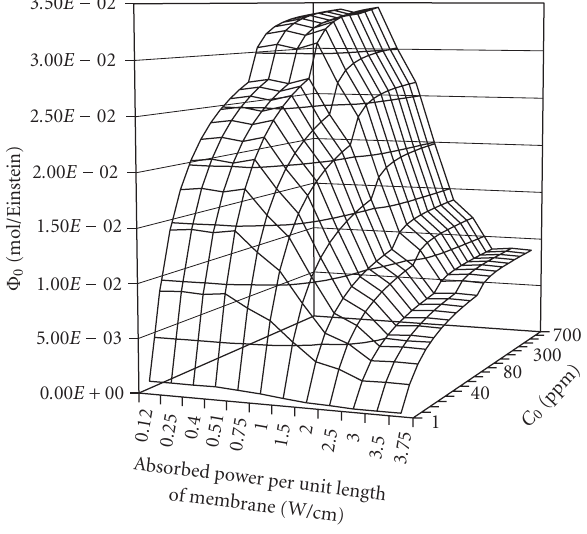
Figure 7: Quantum yields Φ 0 (mol of phenol/Einstein) as a func- tion of initial concentration C 0 expressed as ppm (mass/volume) of carbon and of absorbed power per unit length of lamp (and mem- brane) expressed as Wcm − 1 .